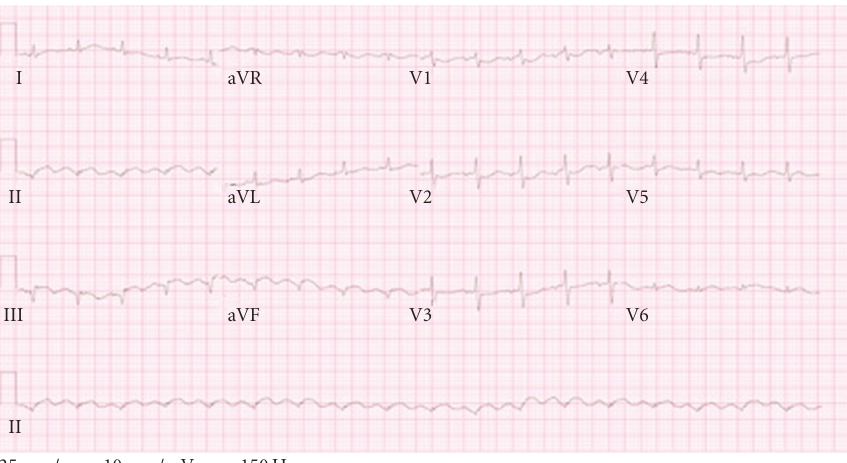
Figure 2: EKG, showing ST-segment elevation in contiguous inferior leads (II, III, aVF), taken after discontinuation of heparin drip and before undergoing coronary artery bypass grafting.